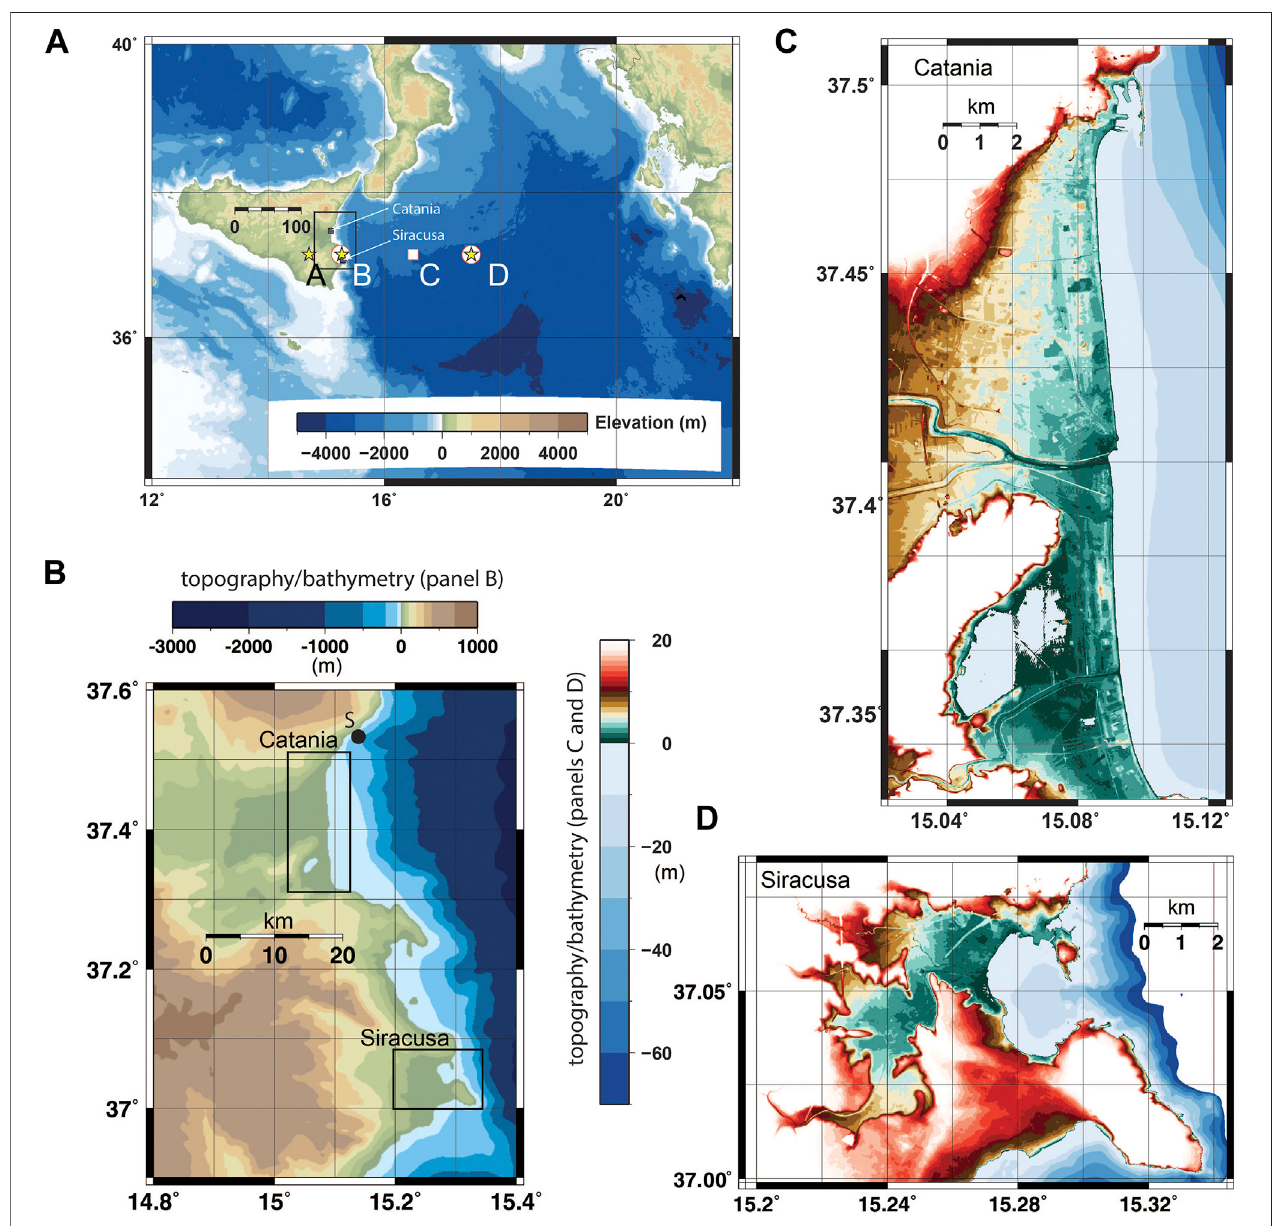
FIGURE1| Mapsatdifferentscalesfortheearthquakesourcesandtsunamiinundation. (A) showsthefaultcentersforallearthquakescenariosconsidered.Points A, B, C, and D are all at latitude 37.15 o , with longitudes 14.70 o , 15.25 o , 16.50 o , and 17.50 o respectively. Yellow asterisks mark the locations of epicenters for scenarios where we examine the effect of the Manning friction coef fi cient. White circles are locations for which we conduct a fi ne scan of strike and dip parameters. The white squaremarkstheepicenterofsourceswherewesearchthestrike,dip,anddepthparameter.Panels (B – D) showhigherresolutionmapsoftheregionssurrounding the towns of Catania and Siracusa, where the tsunami inundation is to be evaluated. The black circle labelled S in panel (B) is the location 37.5368 o N, 15.1333 o E for which the sea height time-series are displayed later.